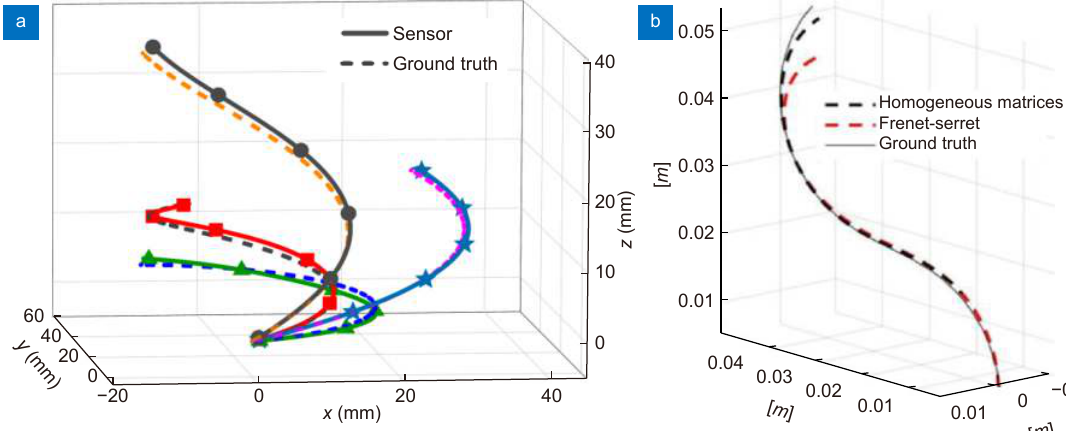
Fig. 8 | Result of test shapes reconstruction. ( a ) 3D shapes − spiral curves with different diameter and pitch (solid − reconstructed curves, dashed − reference curves) 25 . ( b ) 2D shape − S-curve, reference curve (solid line) together with reconstructed curves for algorithms based on the Frenet- Serret equations and homogeneous transformation matrices for m = 100 (dashed lines) 86 . Figure reproduced with permission from: (a) ref. 25 ,